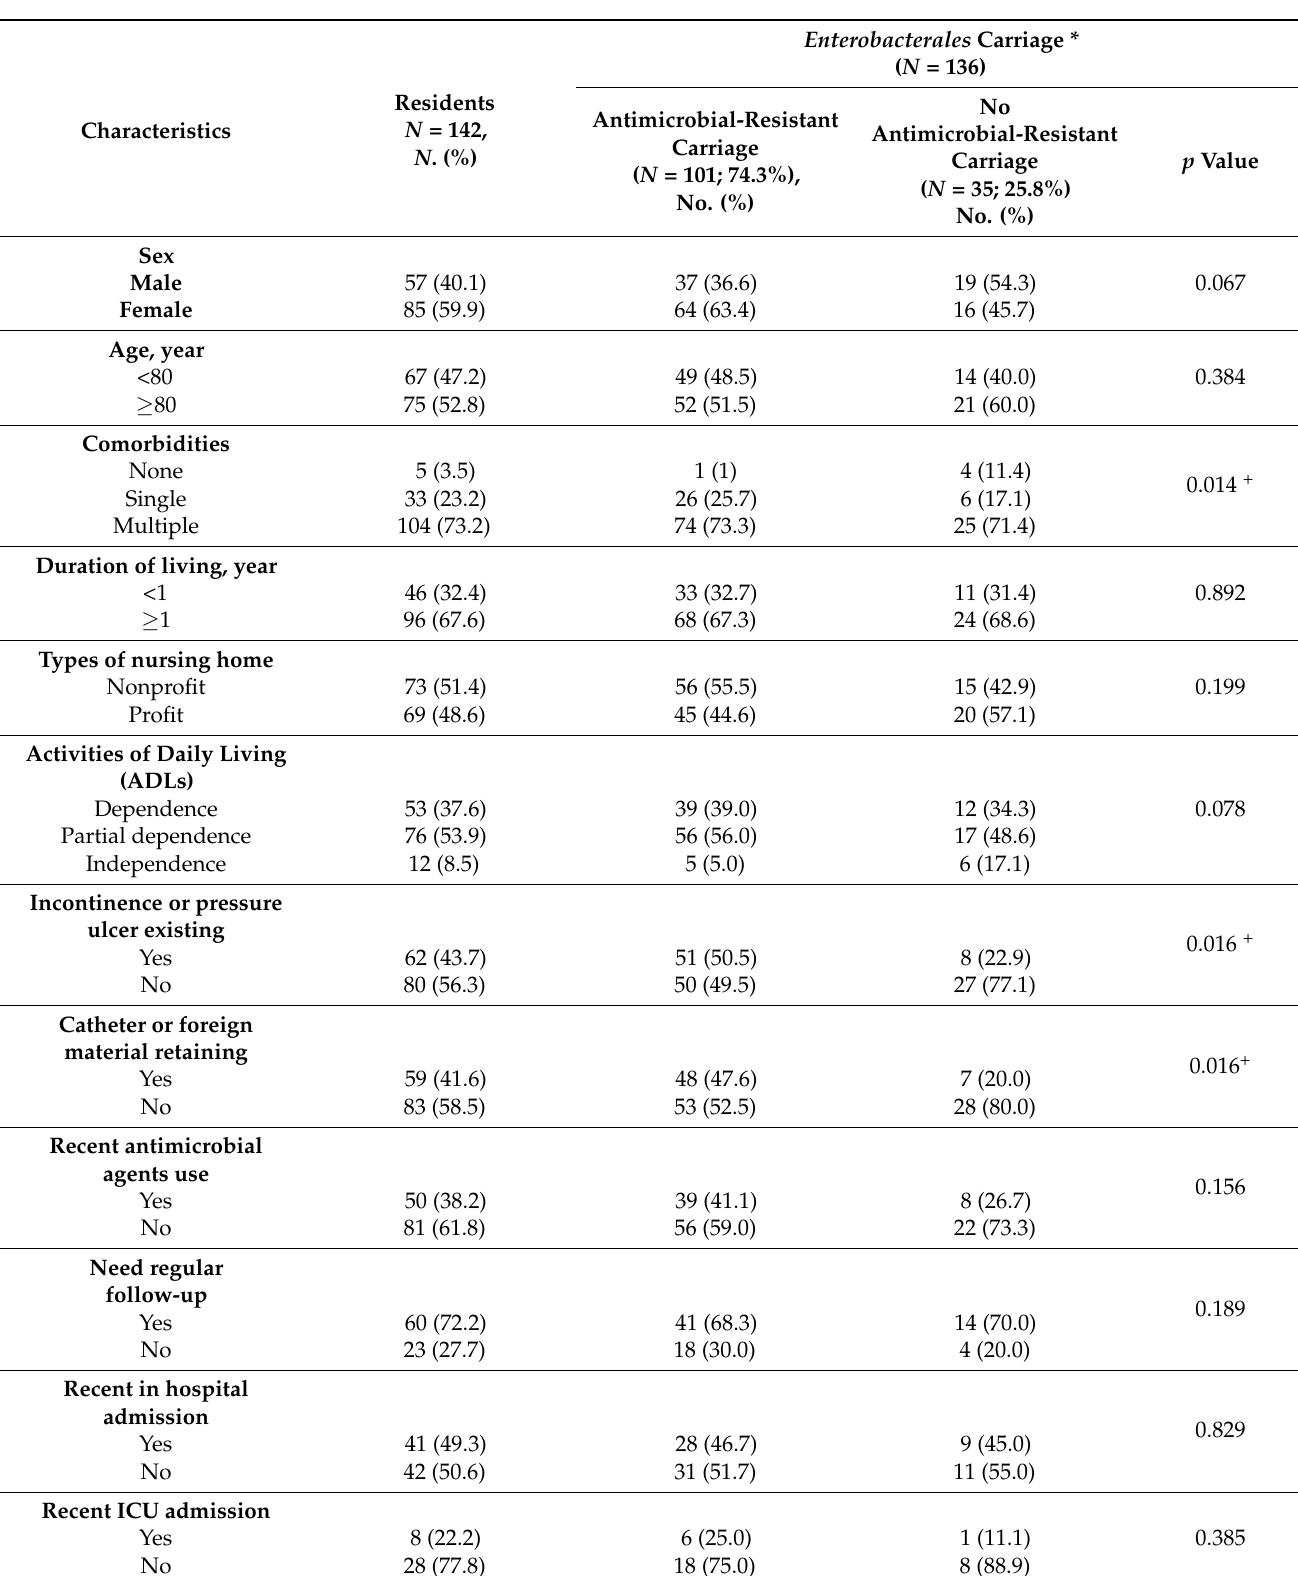
Table 1. Baseline and characteristics of antimicrobial-resistant Enterobacterales carriage of Thai nursing home residents at study